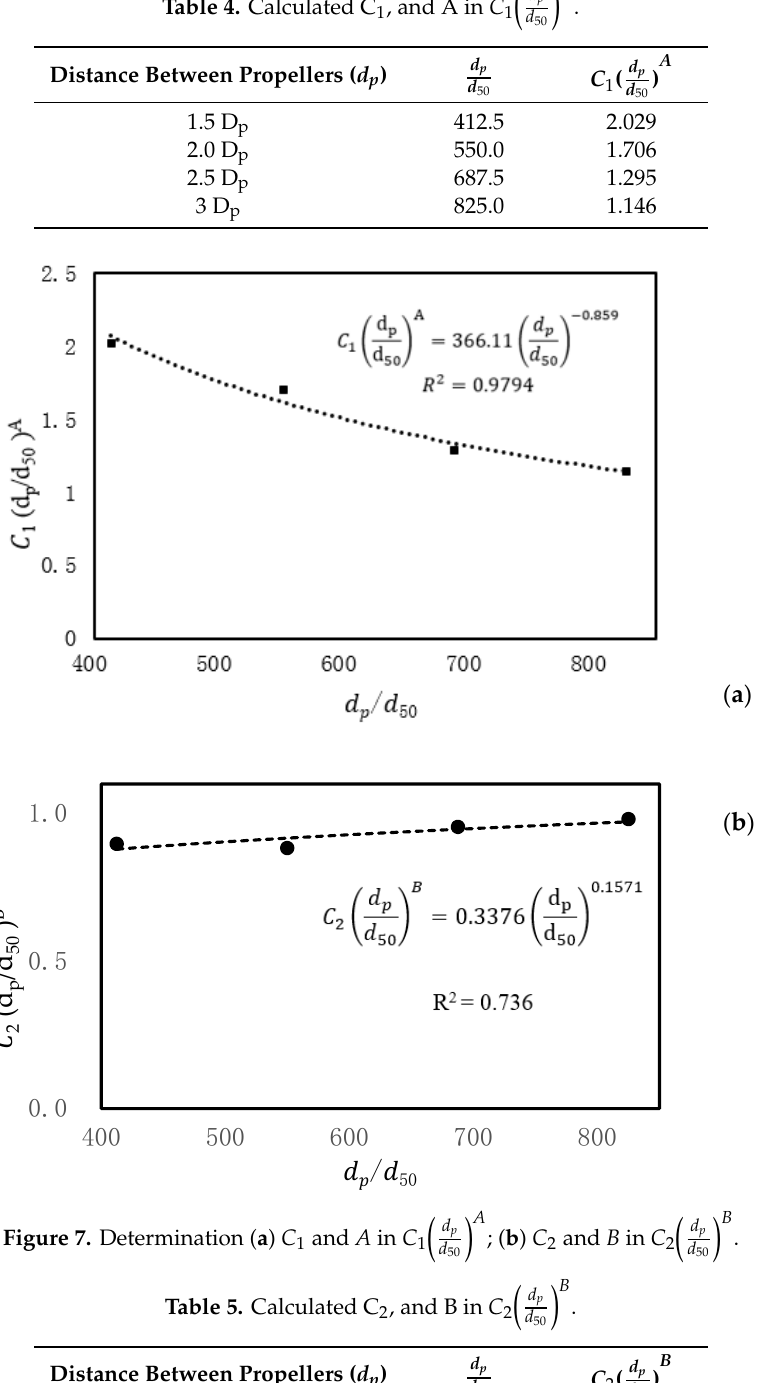
(cid:3003) (cid:3031) (cid:3291) (cid:4673) (cid:3031) (cid:3121)(cid:3116)